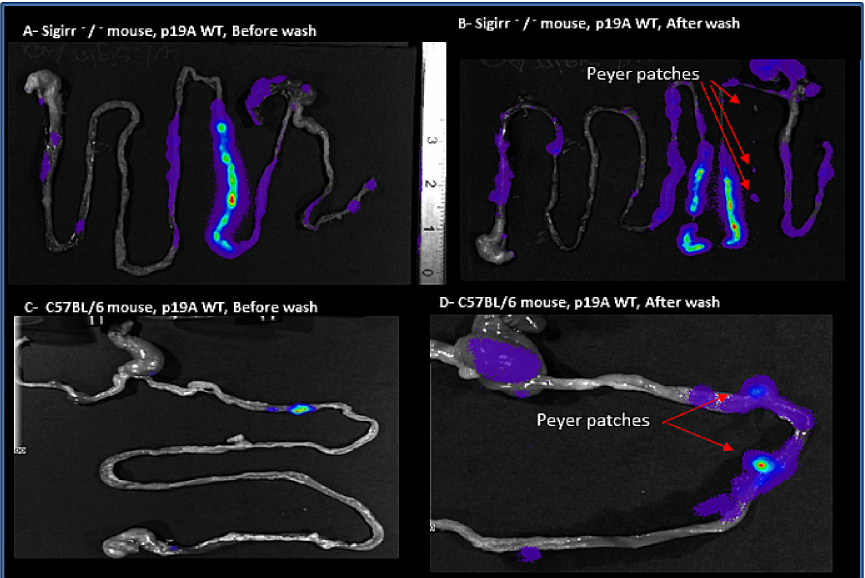
Figure 4. Macroscopic evaluation of the tissues. ( A ) p19A WT infected Sigirr − / − mouse on the 4th day post-infection, expressing luminescent signals from the gastrointestinal tract. ( B ) p19A WT infected Sigirr − / − mouse on the 4th day post-infection, after washing in PBS, expressing luminescent signals from Peyer’s patches, shown with red arrows. ( C ) p19A WT infected C57BL / 6 mouse on the 3rd day post-infection, expressing luminescent signals from the ileum. ( D ) p19A WT infected C57BL / 6 mouse on the 3rd day post-infection, after washing in PBS, expressing luminescent signals from Peyer’s patches, shown with red arrows.